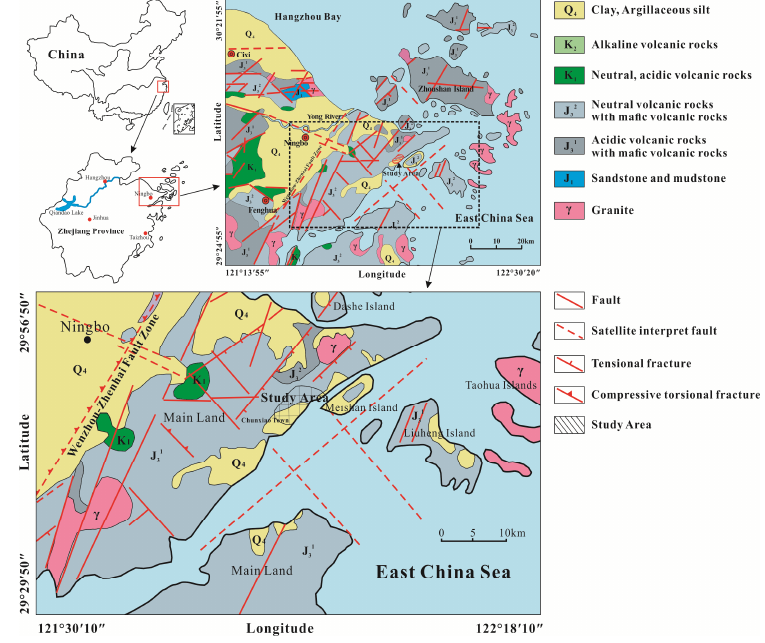
Figure 1. Regional geological structure map.